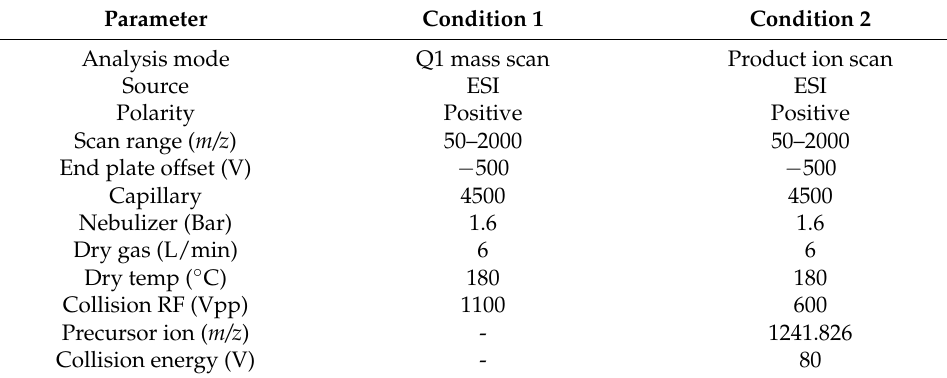
Table 2. Analytical conditions of MS and